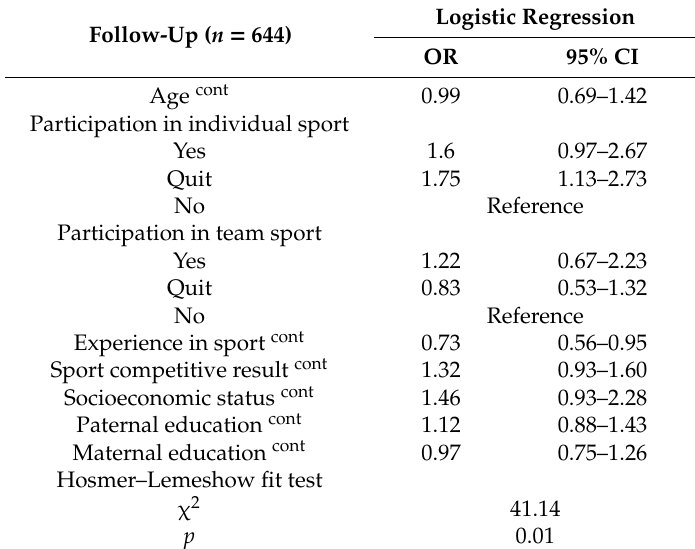
Table 2. Correlates of cannabis misuse at follow-up (adjusted for gender and urban / rural environment).